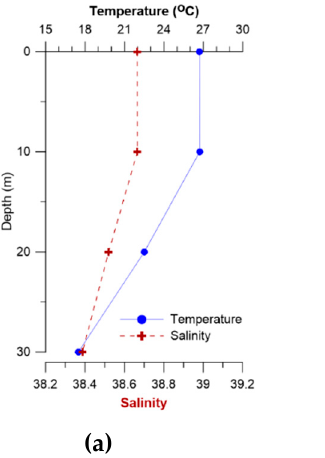
Figure 3. Vertical distribution of physicochemical characteristics. ( a ) Temperature in °C, salinity in psu and ( b ) pH in the NBS scale, Redox potential in mV, DO in µ mol kg − 1 , during field sampling (September 2014).